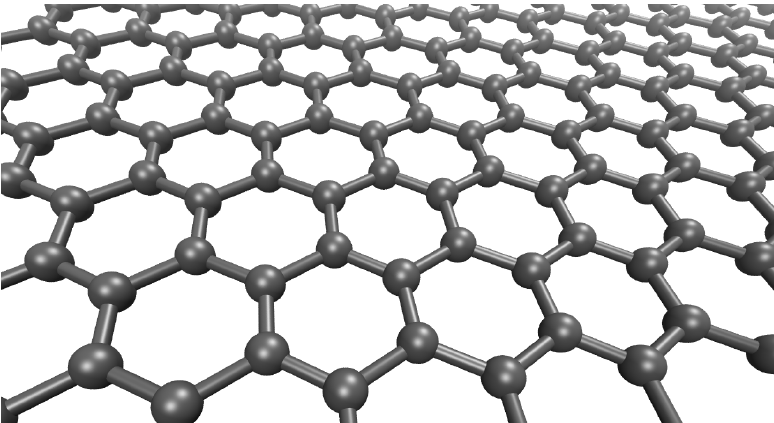
Figure 1. Exemplative ball and stick model of a portion of graphene sheet where carbons atoms are arranged in an hexagonal